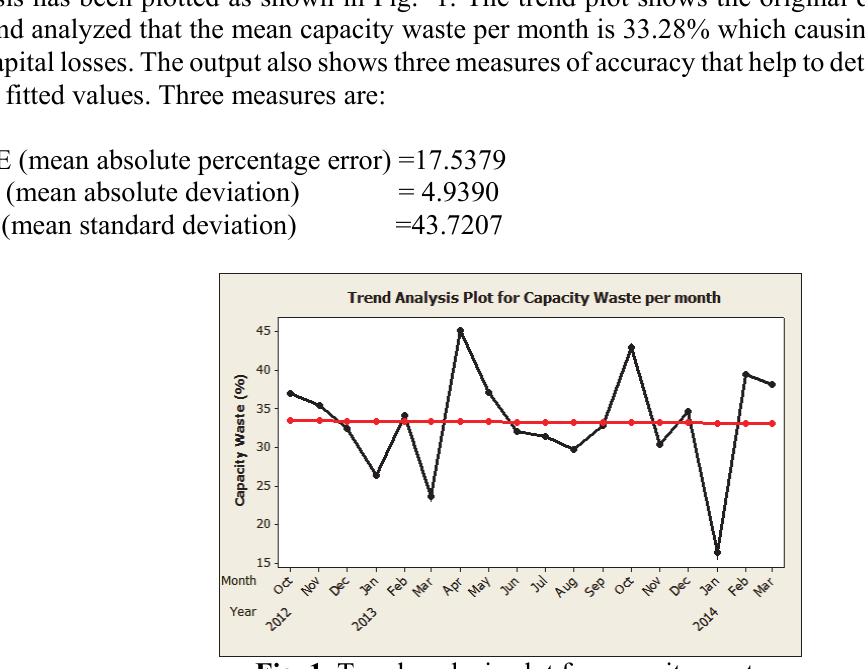
Fig. 1. Trend analysis plot for capacity